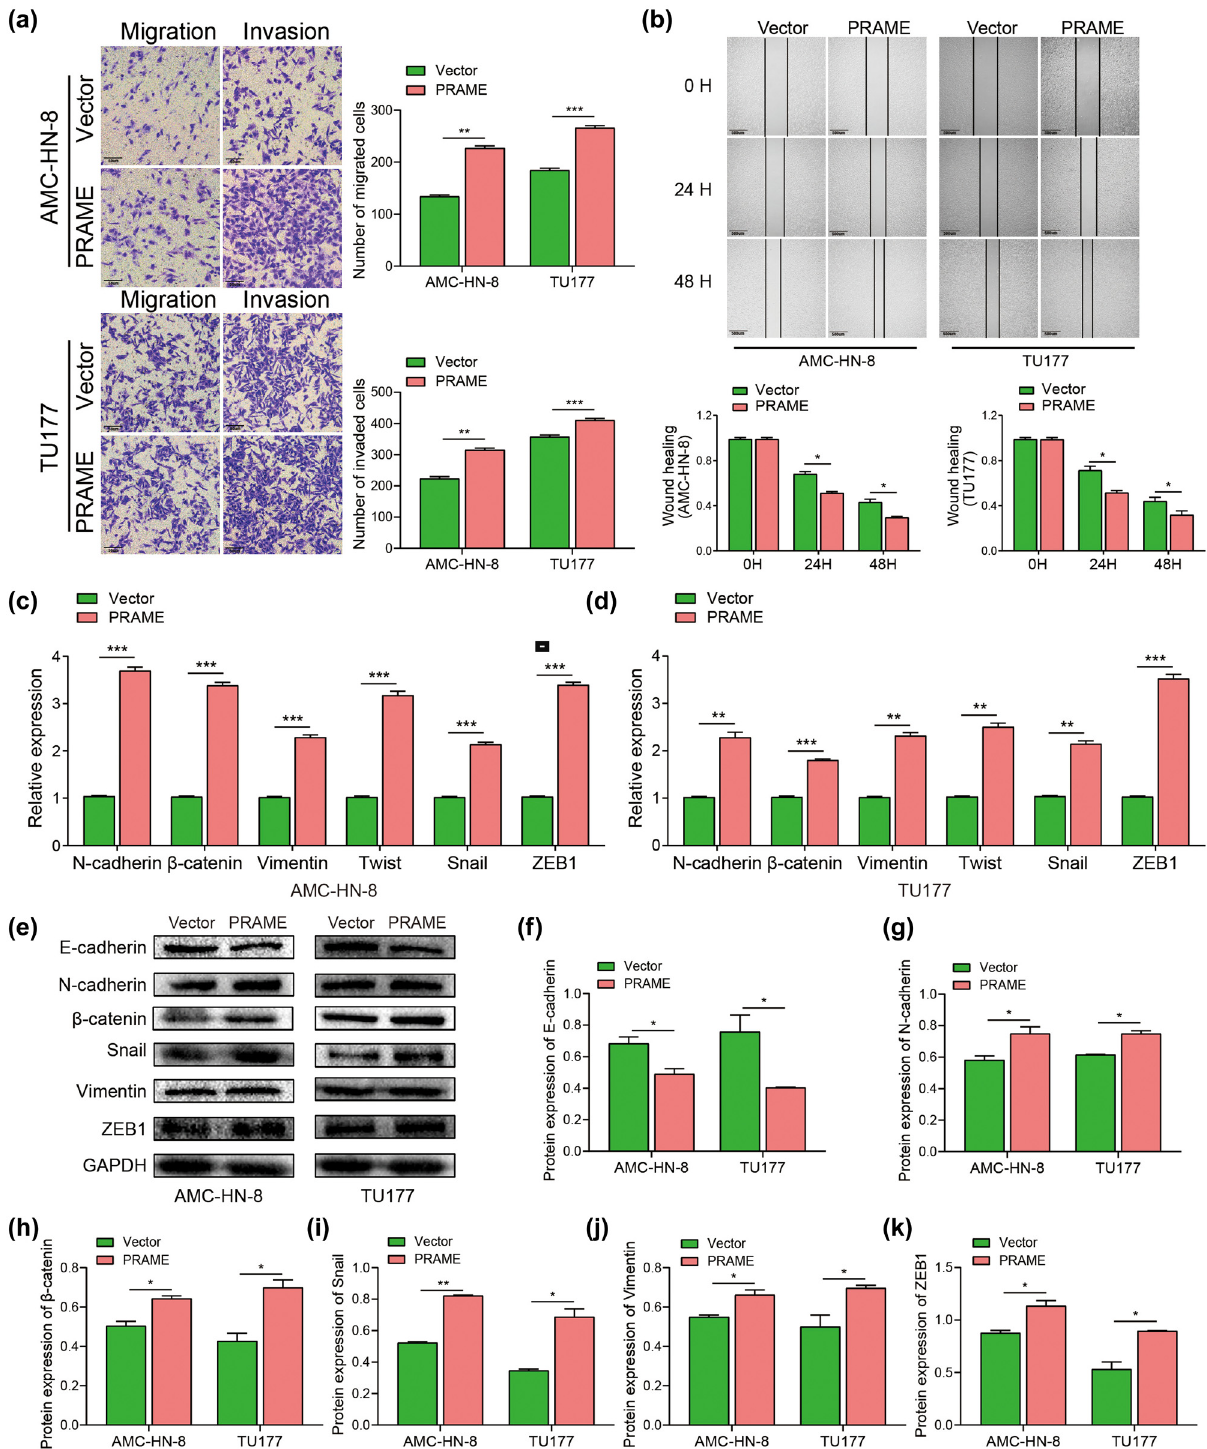
Figure 3: PRAME promotes the migration and invasion of LSCC cells via regulating the EMT. ( a ) PRAME obviously enhanced the migratory and invasive capabilities by transwell assays. ( b ) PRAME notably boosted the migration ability using wound healing assay. ( c and d ) PRAME promoted the mRNA levels of N - cadherin, β - catenin, Vimentin, Twist, Snail, and ZEB1 by means of qRT - PCR. ( e – k ) PRAME suppressed the protein expression of E - cadherin and promoted the protein expression of N - cadherin, β - catenin, Vimentin, Snail, and ZEB1 by means of western blot assay ( * P < 0.05, ** P < 0.01, *** P < 0.001 )